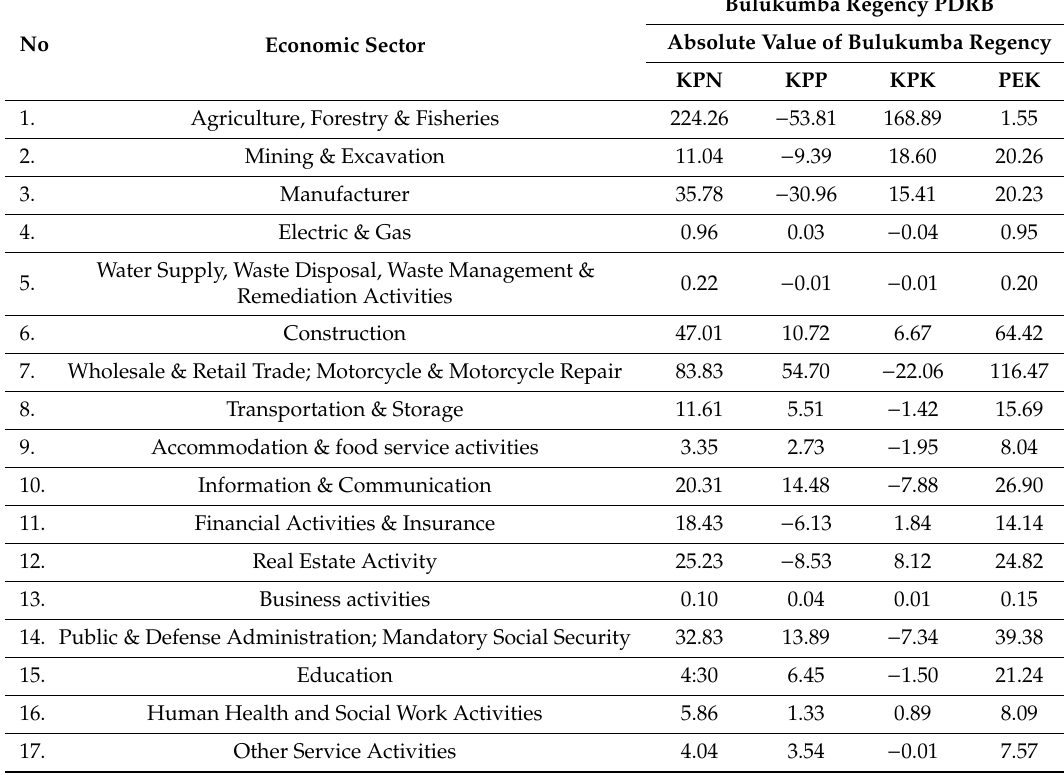
Table 4. Changes in Economic Growth in the District of